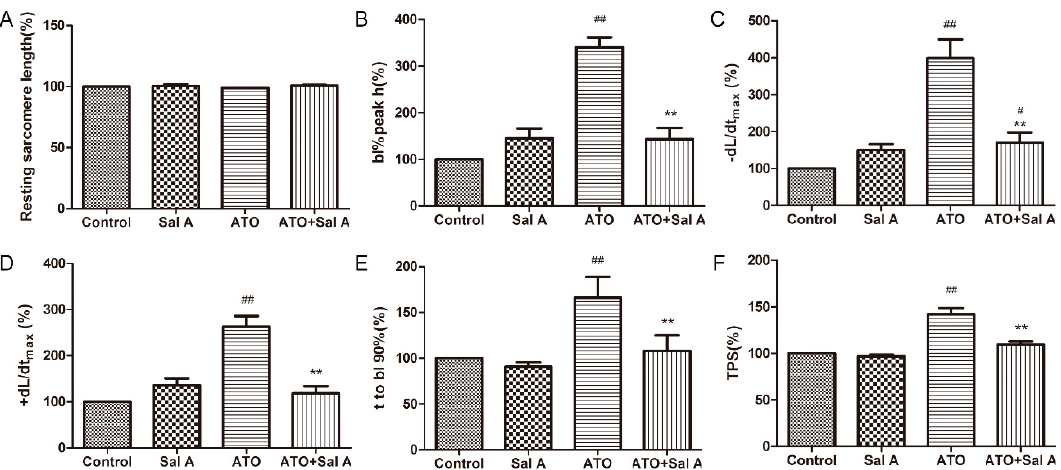
Figure 4. Sal A enhanced contractile function of adult rat ventricular myocytes (ARVMs) after ATO treatment. ( A ) Resting sarcomere length. ( B ) Sarcomere-shortening amplitude. ( C ) maximal relengthening velocity ( − dL/dtmax). ( D ) maximal shortening velocity (+dL/dtmax). ( E ) time to 90% relengthening. ( F ) time to peak shortening (TPS). Data are expressed as the mean ± SD ( n = 30–40 per group), # p < 0.05 vs. control, ## p < 0.01 vs. control, ** p < 0.01 vs. ATO.